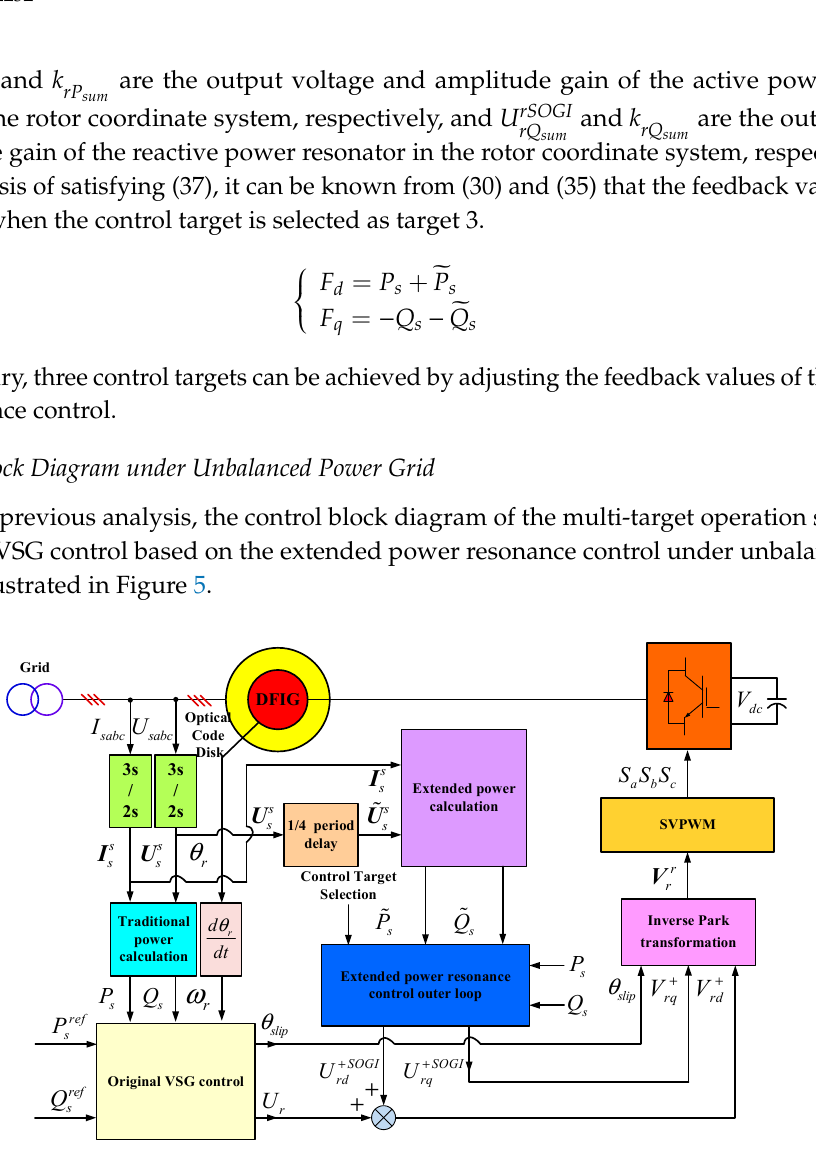
Table 1. System parameters of the doubly fed induction generator (DFIG) control system. Motor Parameters